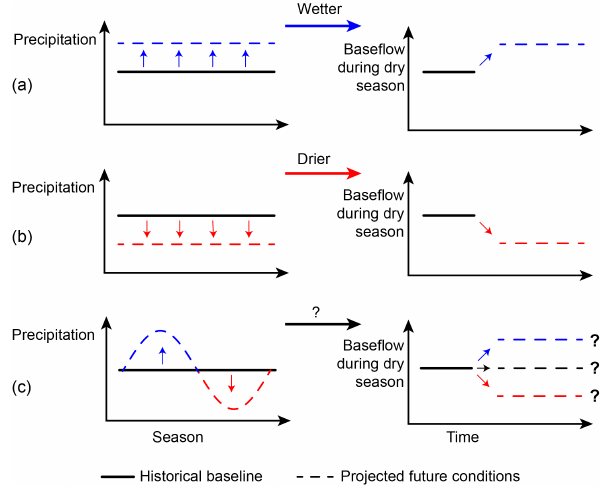
Figure 1. Schematic direction of change of natural baseflow in the dry season under different climate change scenarios: (a) all seasons becoming wetter, (b) all seasons becoming drier and (c) seasonal shift of precipitation.